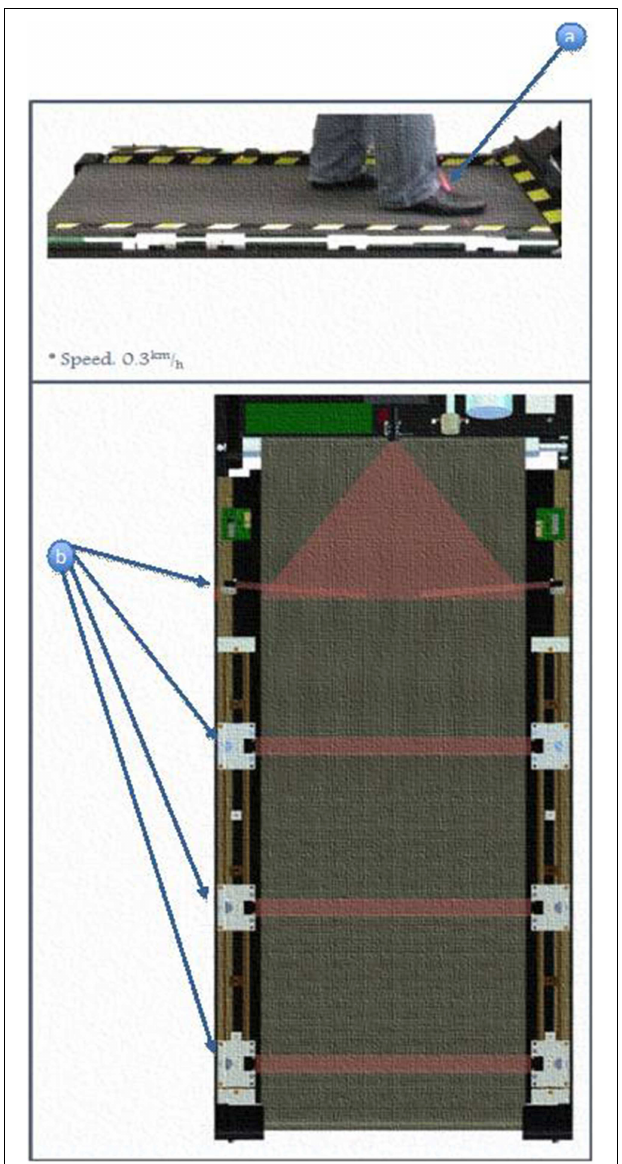
FIGURE 2 | Positioning an activation of laser beam sensors. (a) Subjects’s foot triggers the motion of the treadmill. (b) Different locations of the light beam